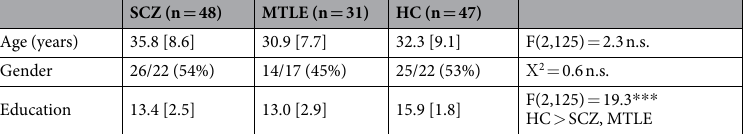
Table 2. Basic sociodemographic and clinical characteristics of the participants of the study. All of the values are given in M [SD] format with the exception of gender, where the M/F ratio is given. SCZ – patients with schizophrenia; MTLE – patients with mesial temporal lobe epilepsy; HC – healthy